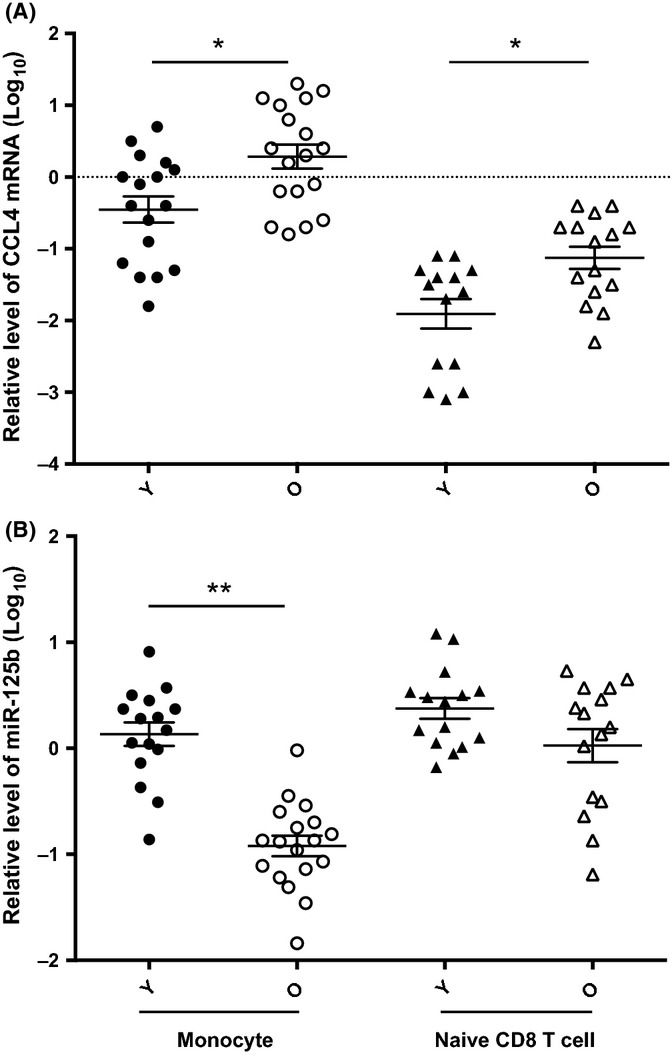
Inverse correlation of CCL4 and miR-125b expression in human monocytes and CD8 naïve T cells. (A) Relative CCL4 mRNA level in monocytes and naïve CD8 T cells in young and old adults. Monocytes (Young ≤ 42 years, N = 16 and Old ≥ 70 years, N = 18), naïve CD8 T cells (Young = 15 and Old = 15), were isolated from blood of young and old adults by immunomagnetic separation and cell sort, and CCL4 mRNA level were measured by RT-qPCR and first normalized to ACOX-1 and then normalized to a standard generated from PBMCs of five normal subjects (Log10). (B) Relative miR-125b level in monocytes (Young = 16 and Old = 18) and naïve CD8 T cells (Young = 15 and Old = 15) in young and old adults. miR-125b level was measured by RT-qPCR and first normalized to RNU6B and then normalized to a standard generated from PBMCs of five normal subjects (Log10). Multifactor ANOVA with Benjamini–Hochberg procedure was used, and ** and *P < 0.01 and <0.05, respectively.